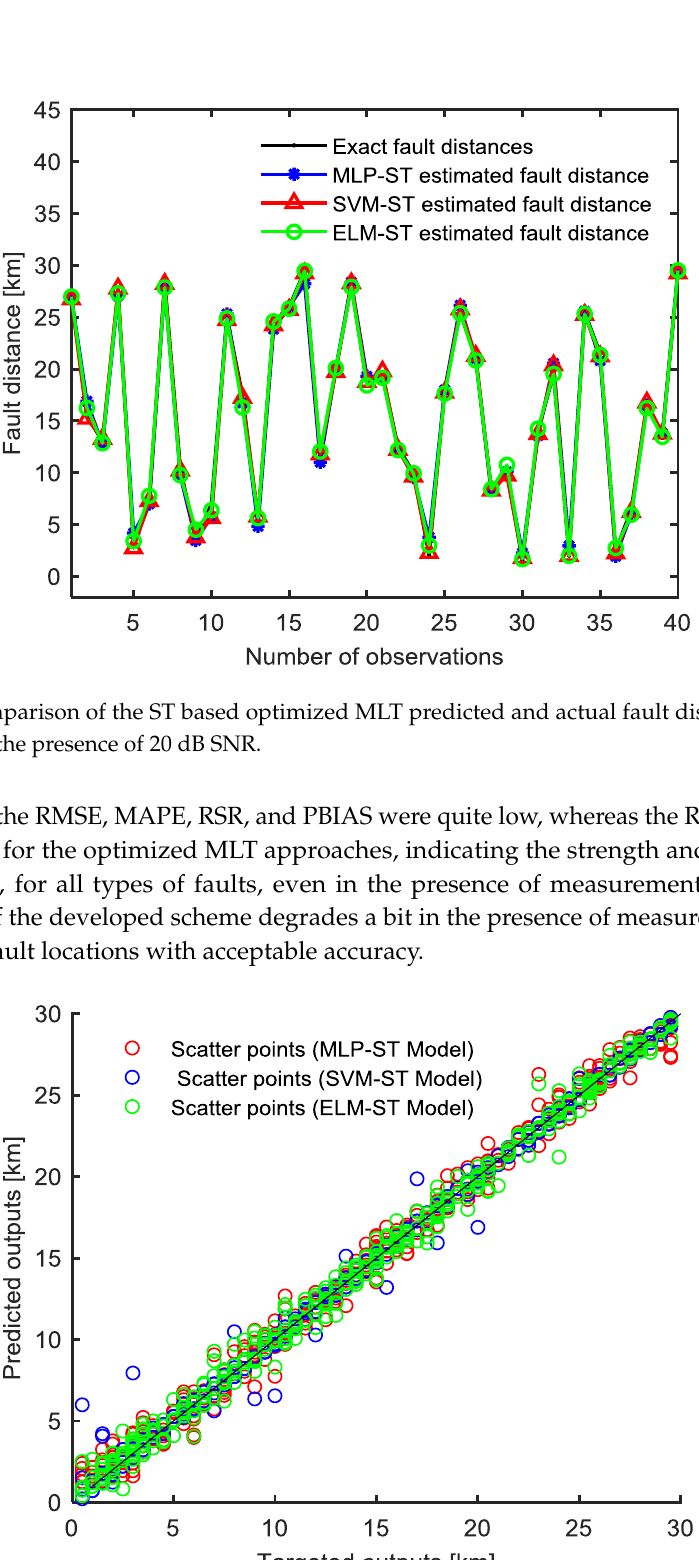
Figure 9. Scatter plot of the targeted and the ST based optimized MLT predicted outputs, for the test dataset, in the presence of 30 dB SNR.